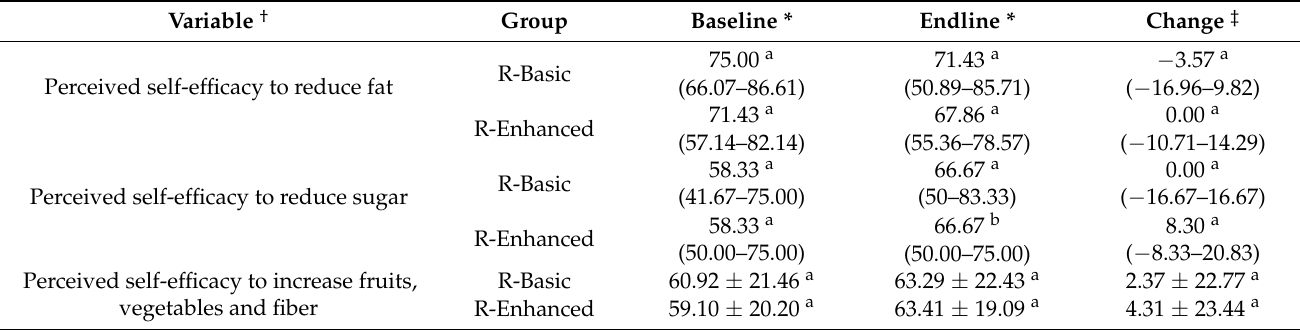
Table 5. Perceived Self-Efficacy for choosing healthier foods and increasing physical activity in Rashakaty Basic ( n = 54) and Rashakaty Enhanced n = 111)